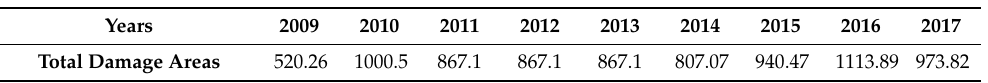
Table A2. The total damage area (hm 2 ) by Lophodermium piceae of the nine years after the Wenchuan